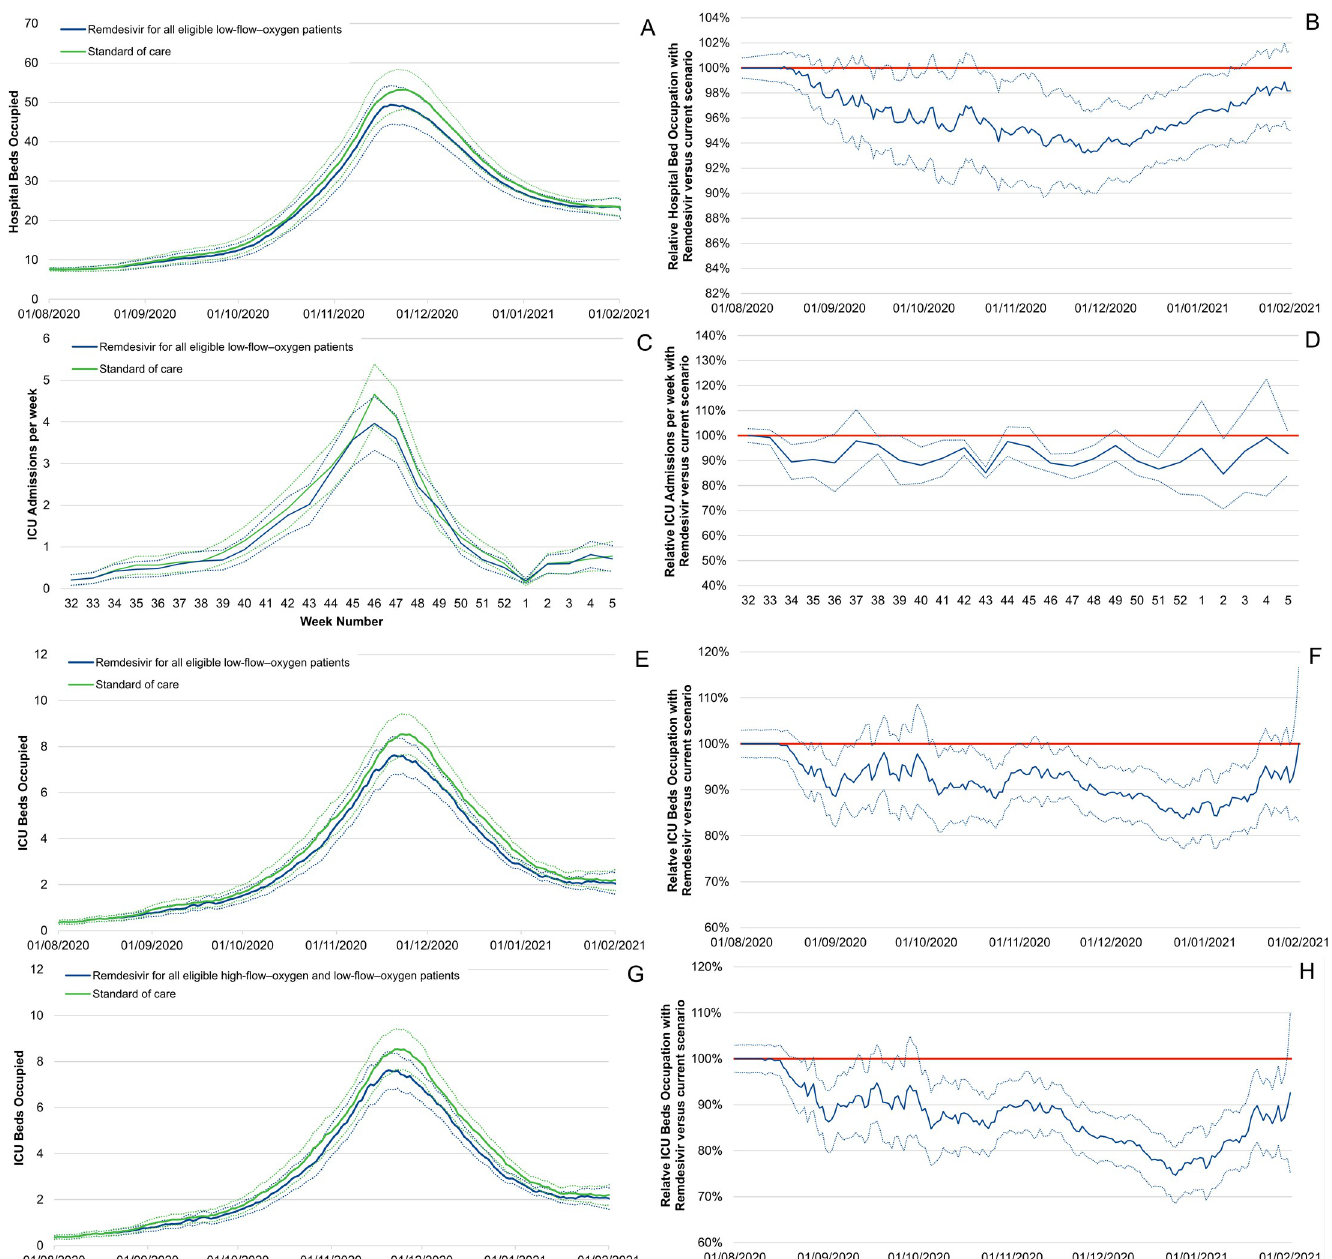
Fig 2. Estimations of the number of hospital beds occupied per day per 100,000 inhabitants (A), hospital bed occupancy associated with remdesivir use for all eligible low-flow-oxygen patients (scenario a) and all eligible low-flow and high-flow-oxygen patients (scenario b) relative to standard of care (B), ICU admissions per week per 100,000 inhabitants (C), ICU admissions associated with remdesivir use for all eligible low-flow-oxygen patients (scenario a) relative to standard of care (D), number of ICU beds occupied per day per 100,000 inhabitants (E) and ICU bed occupancy associated with remdesivir use for all eligible low-flow-oxygen patients (scenario a) relative to standard of care (F), number of ICU beds occupied per day per 100,000 inhabitants (G) and relative ICU bed occupancy associated with remdesivir use for all eligible low-flow- and high-flow-oxygen patients (scenario b) relative to standard of care (H) between 01/08/2020 and 01/02/2021. Remdesivir use has been limited to all eligible low-flow patients since